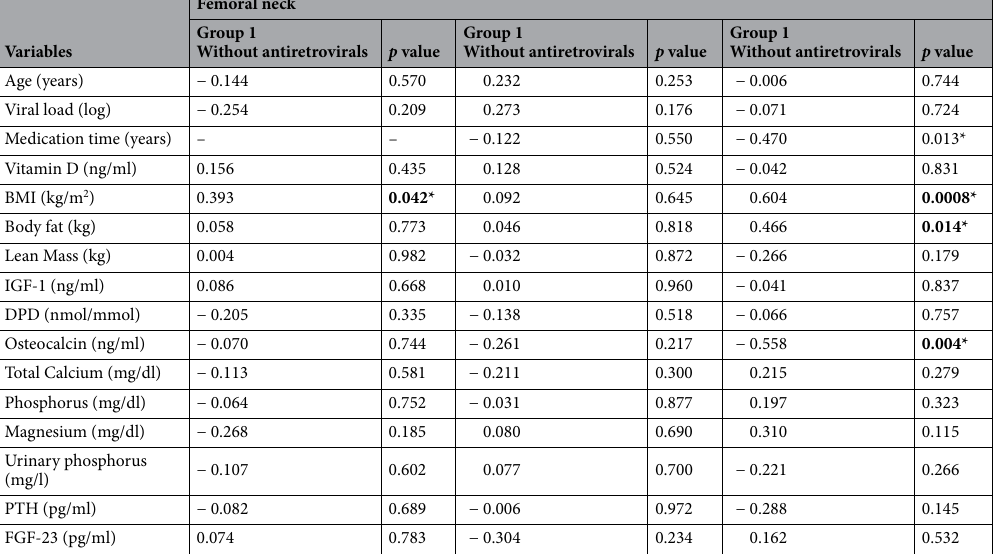
Table 4. Correlation by groups between biochemical markers, body composition and viral parameters with bone mineral density of the femoral neck in patients with chronic hepatitis B virus infection in use or not of antiretrovirals. Parameters with statistical differences are given in bold. Pearson correlation, significance level p ≤ 0.05 indicated by *. DPD, deoxypyridinoline; PTH, parathormone; IGF-1, insulin-like growth factor-1; FGF-23, fibroblast growth factor 23; BMI, body mass index. FGF-23 n = 16–17 per